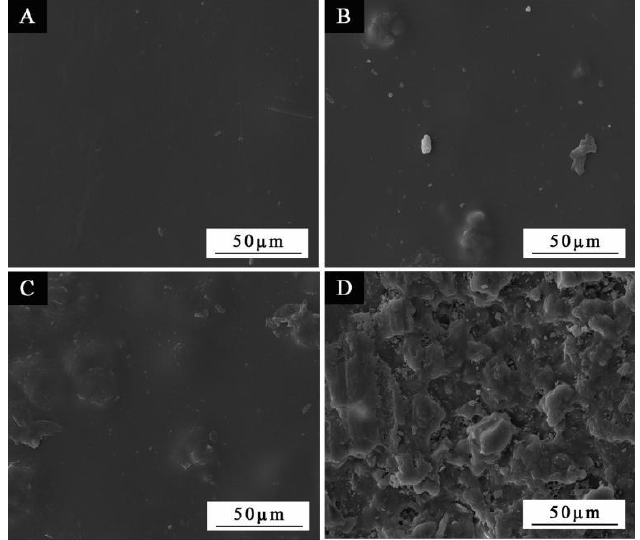
Figure 5. SEM of the waterborne primer coatings with different mass fractions of microcapsules (the core–shell ratio is 0.67:1): ( A ) 0; ( B ) 5.0%; ( C ) 10.0%; ( D ) 25.0%.